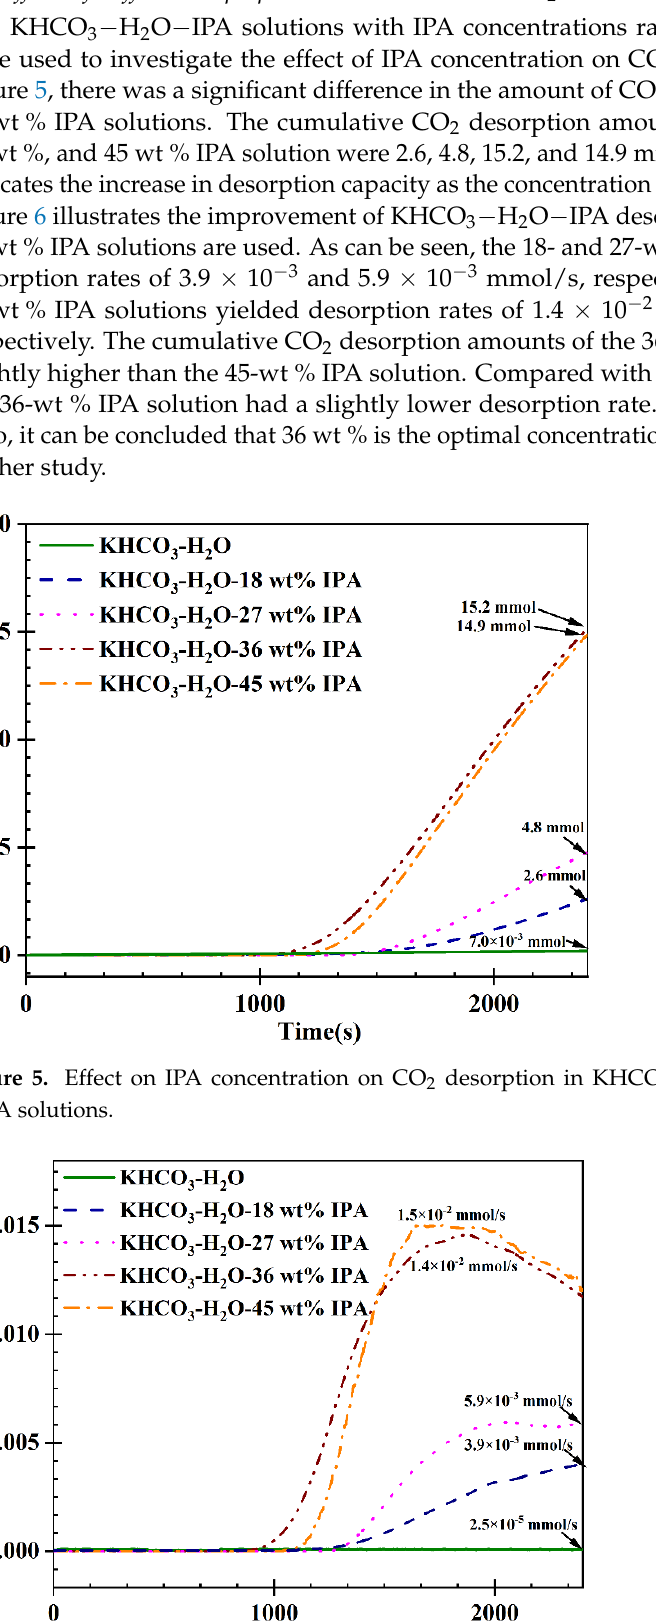
− H − H − IPA 2 O and KHCO 3 2 O